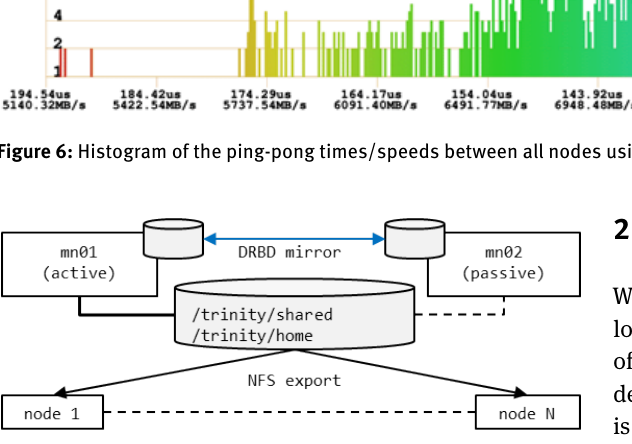
Figure 7: Organization of the “Zhores” cluster management with Luna